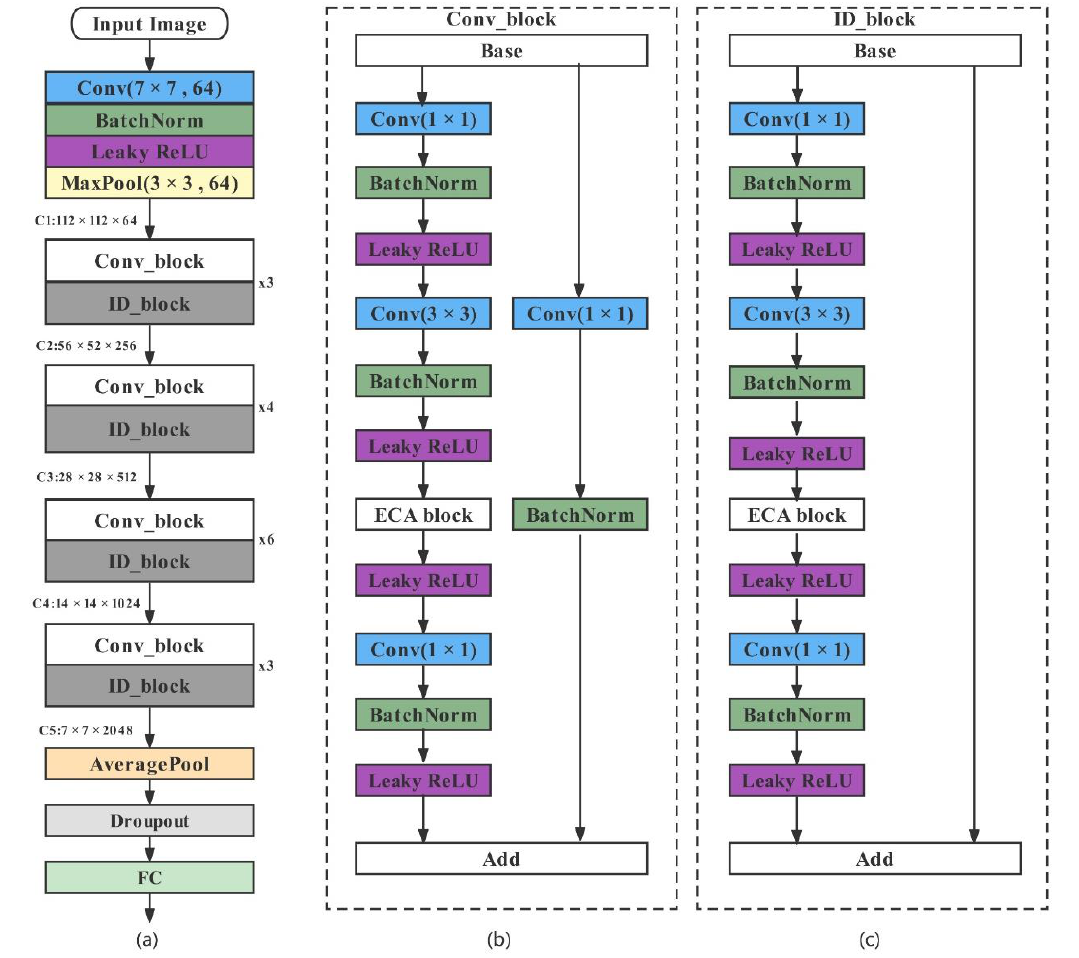
Figure 6. Structure of the improved model. ( a ) Backbone structure; ( b ) Conv_block; ( c ) ID_block. Note: Conv is Conv Layer; BatchNorm is Batch Normalization; ID_Block is identity block; Conv_block is convolution block; FC is full connection;ECA block is Efficient Channel Attention block.